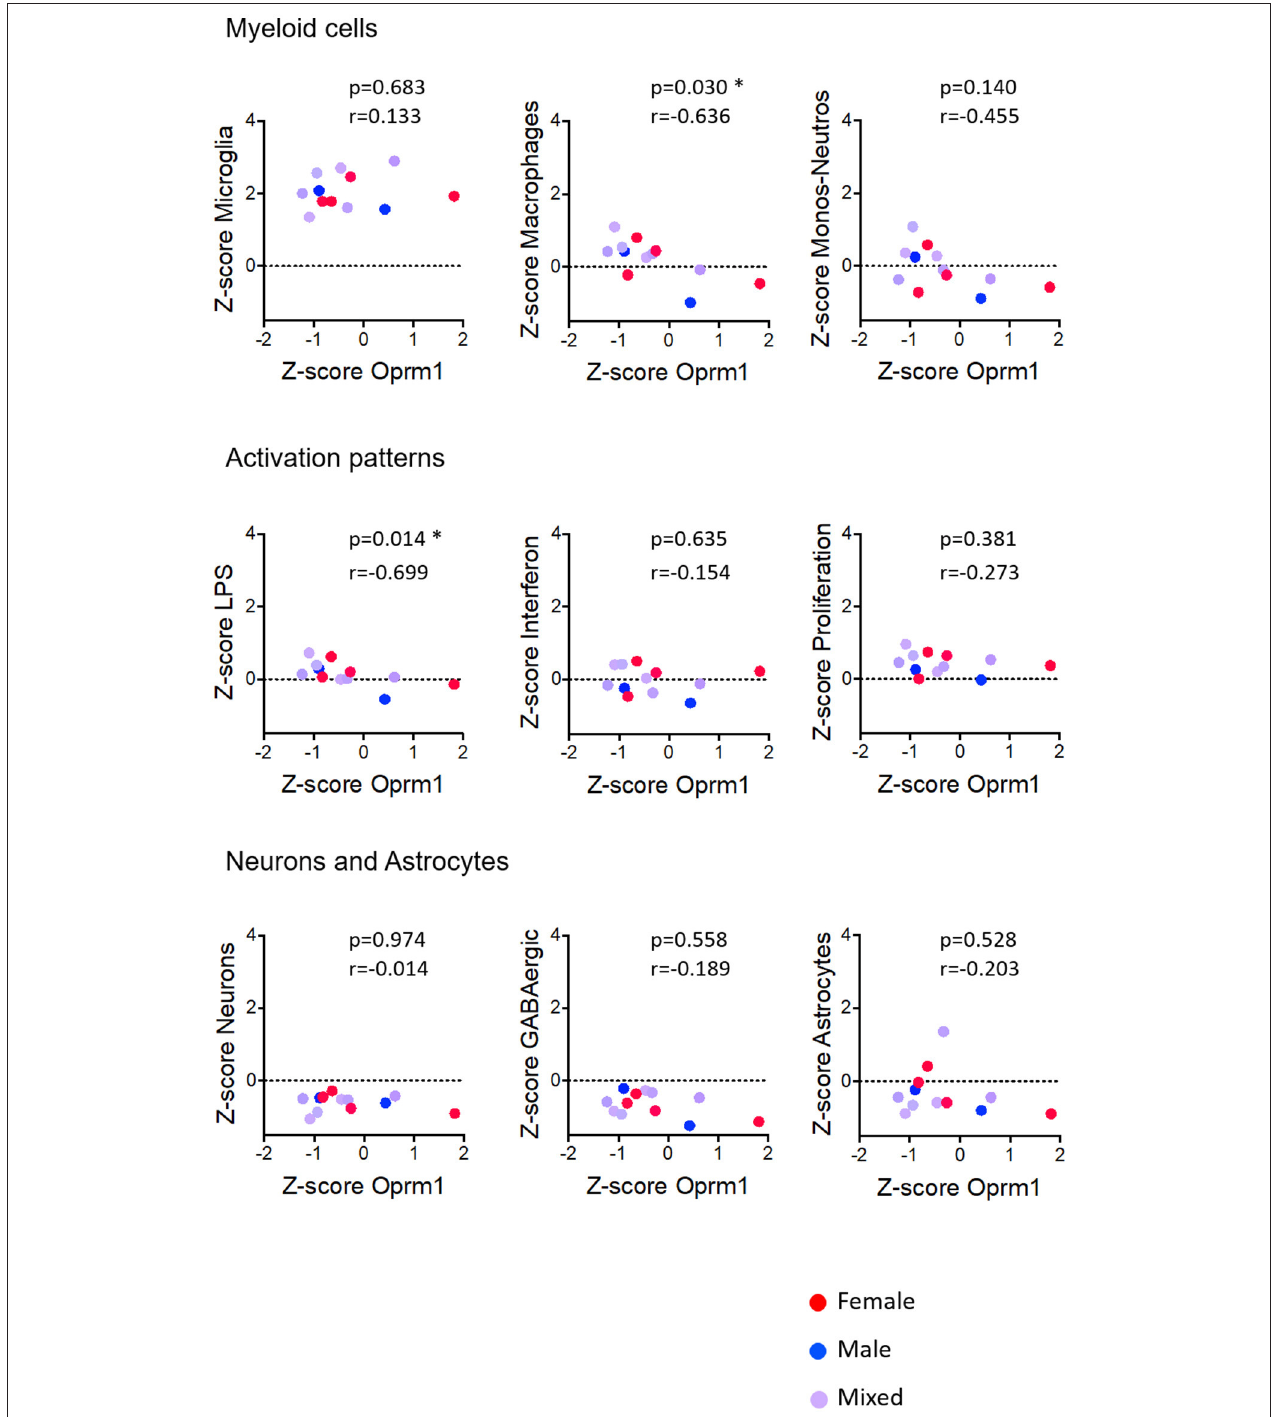
FIGURE 5 | Correlation of Oprm1 gene expression within the Myeloid cells, Activation patterns, and Neurons and Astrocytes gene clusters in mouse whole brain datasets. Oprm1 expression does not correlate with the microglia-related and the Monocyte-Neutrophil-related genes ( p > 0.05, ns) but is significantly negatively correlated with the Macrophages-related genes ( r = 0.636; * p = 0.03). Oprm1 expression has a negative correlation ( r < 0) with all the Activation patterns-, Neurons, and Astrocytes gene clusters, which is only statistically significant for the LPS-related gene module (* p = 0.014). All correlations were determined with the Spearman’s correlation